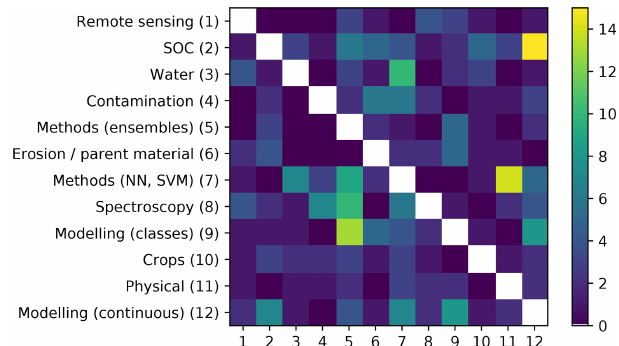
Figure 10. Co-occurrence between the two most likely topics per document. Values correspond to the number of papers.